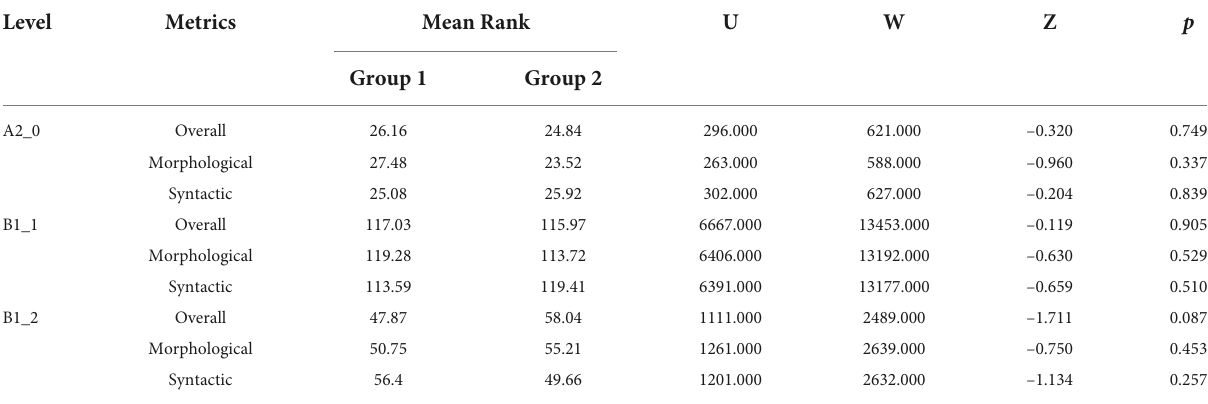
TABLE 5 Mann–Whitney U results on each proficiency level between two pseudo-level